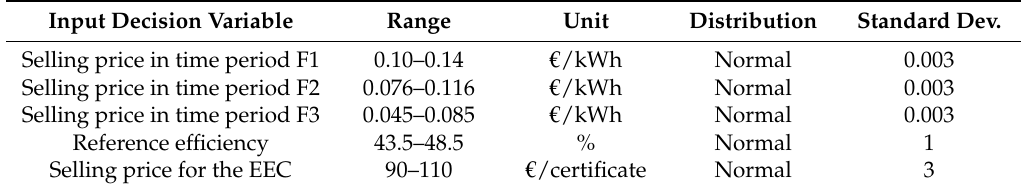
Figure 11. Deterministic and probabilistic approaches to vector optimization. Table 4. Probabilistic decision variables adopted in the second MORDO problem.